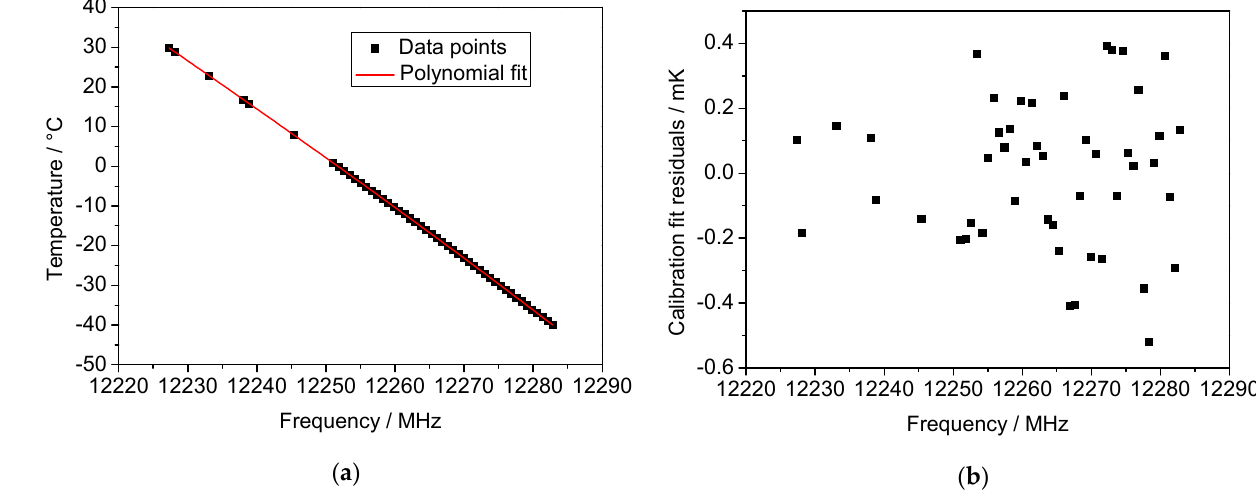
Figure 10. ( a ) Resonant frequency for WGM n=5 as a function of the temperature: a 5th order polynomial function (red line) was used to fit the experimental data points. ( b ) Calibration fit residuals: all the points are within ±0.6 mK.